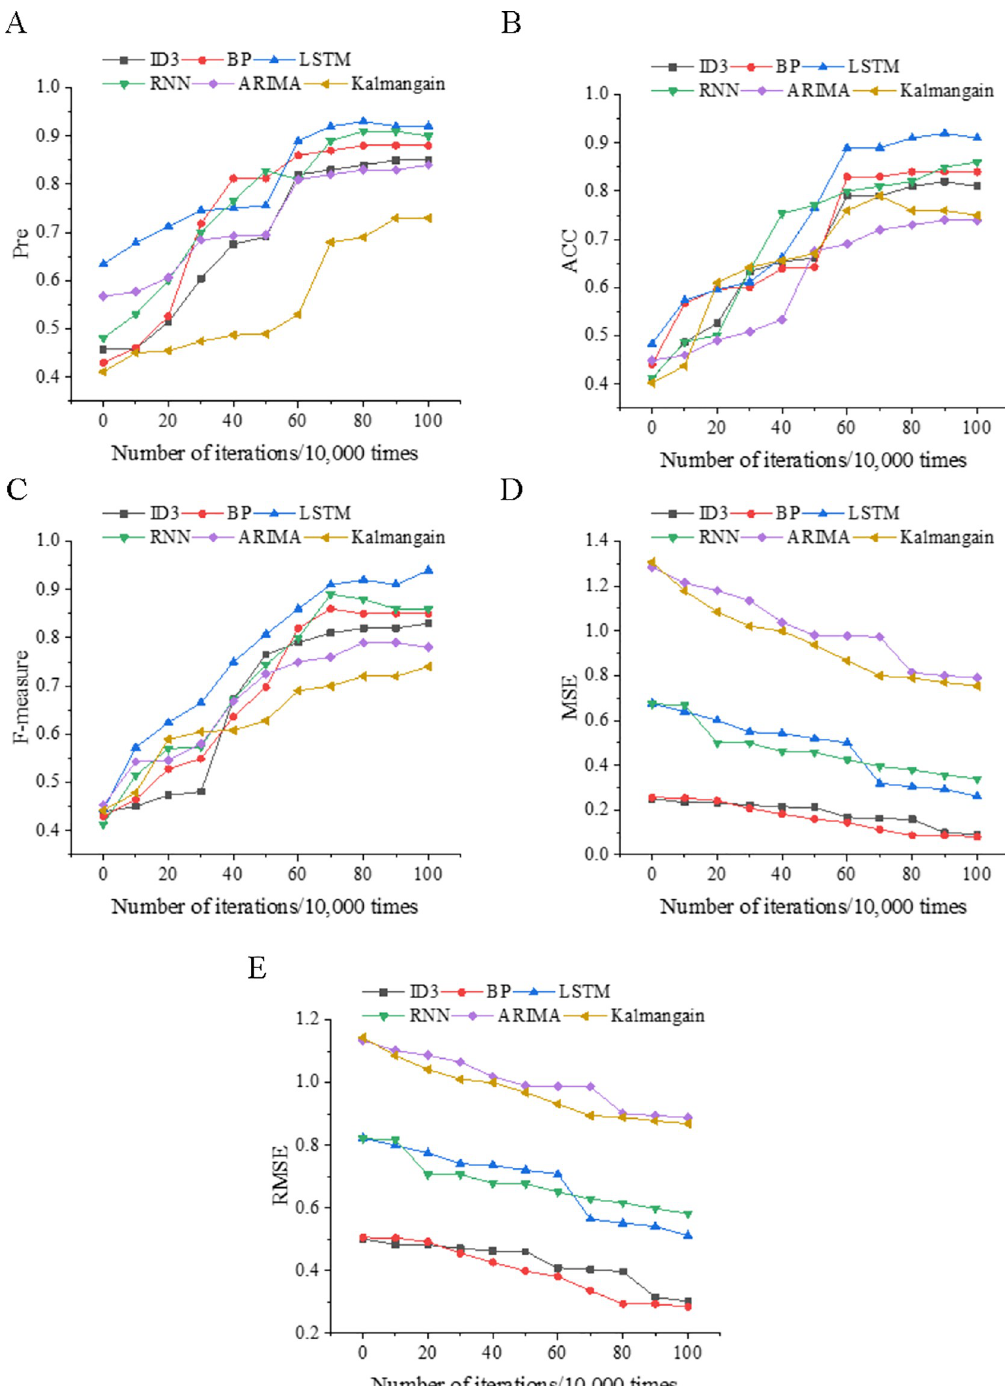
Fig 10. Trajectory prediction results based on LSTM network. Note: common trajectory prediction algorithms include ID3 (Iterative Dichotomiser 3), BP (Backpropagation), RNN, ARIMA (Autoregressive Integrated Moving Average model), and Kalman